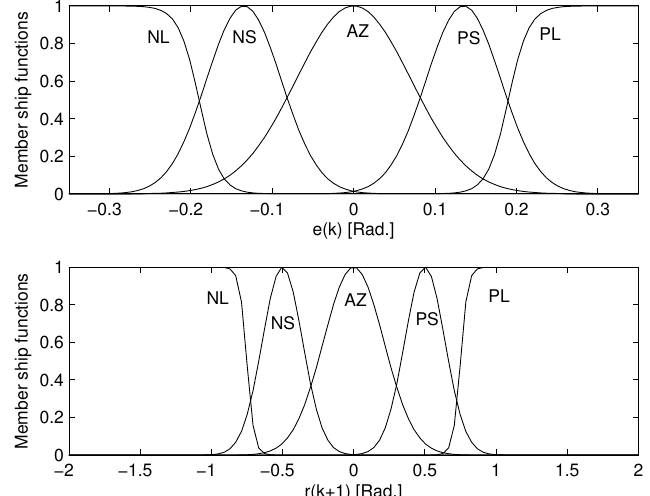
Figure 5. Membership functions of the MiFREN controller: e ( k ) and r ( k + 1 ) .